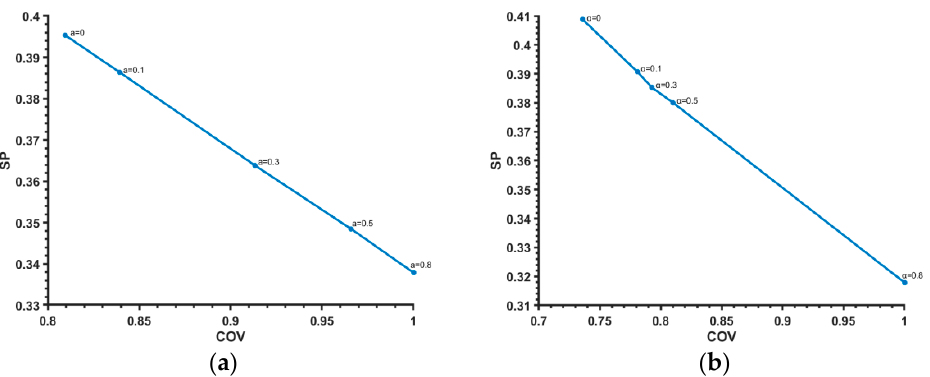
Figure 10. The curve of cov-sp values under di ff erent α values. ( a ) The 0th cluster ( b ) The 1st clus-